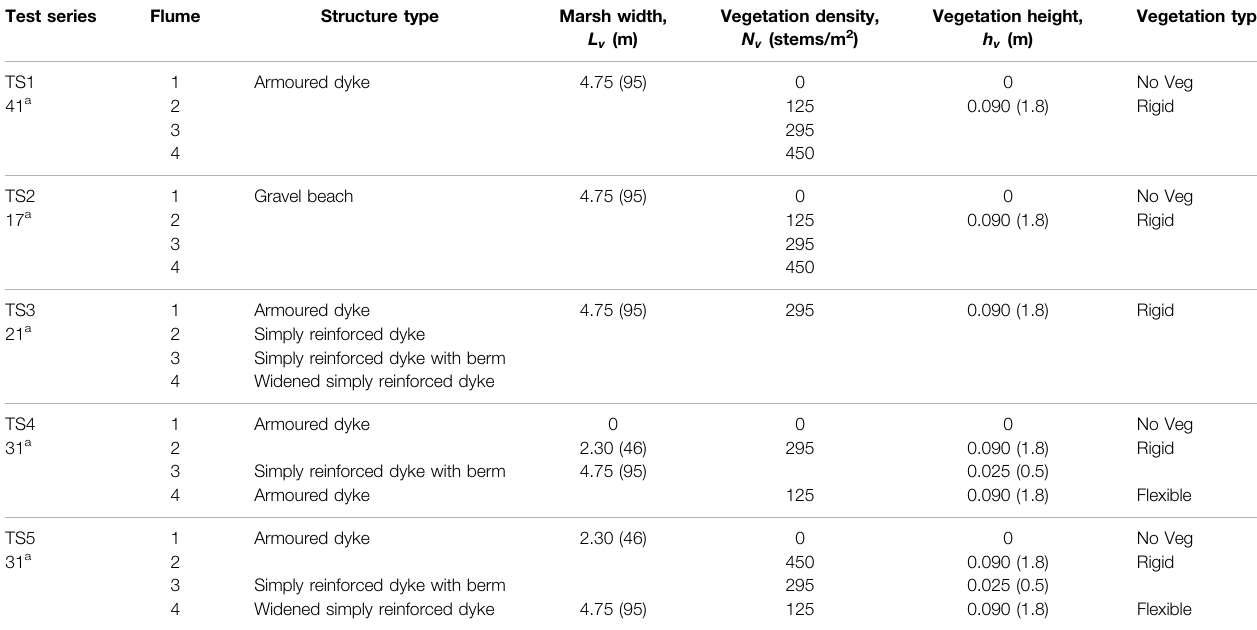
TABLE 2 | Experiment setup for Test Series 1 – 5. Test